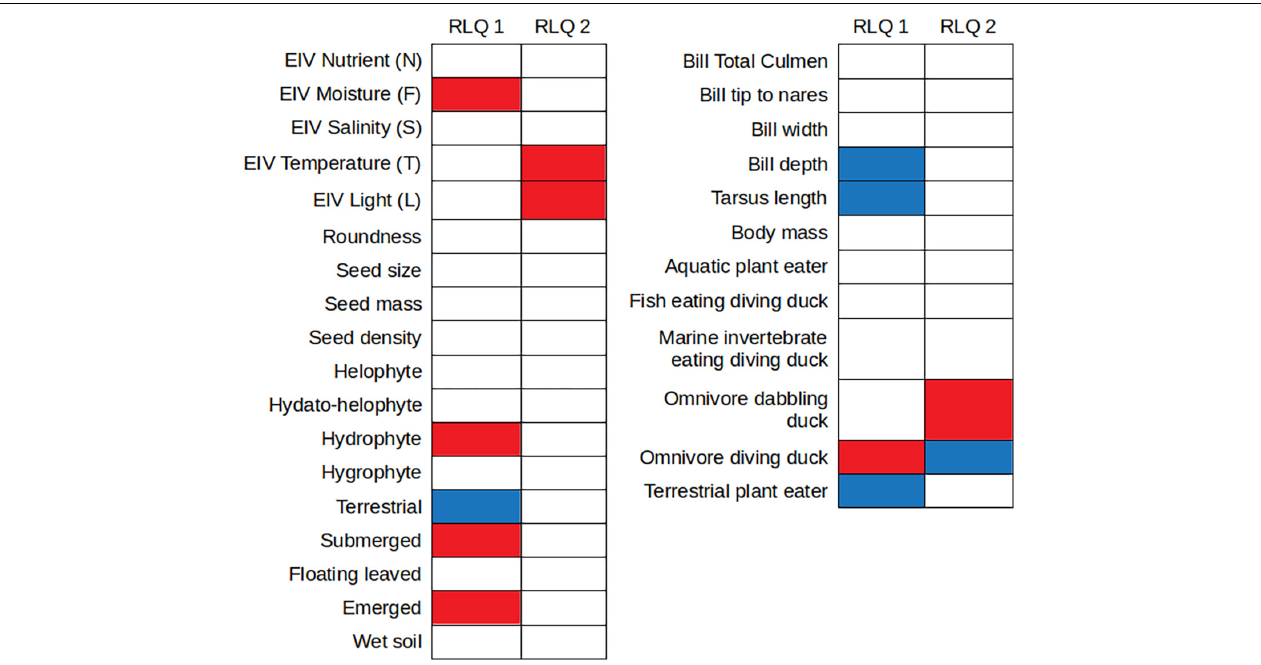
FIGURE 3 | Results of the fourth-corner tests on the associations of each plant and waterfowl trait with the first two axes of the RLQ. Blue and red cells represent, respectively, positive and negative significant associations. White cells represent associations not considered as significant by the fourth-corner tests. These results indicate associations between geese species and terrestrial plants, between omnivorous diving ducks and strictly aquatic plants, and between dabbling ducks and plants that prefer higher temperature and light exposure.